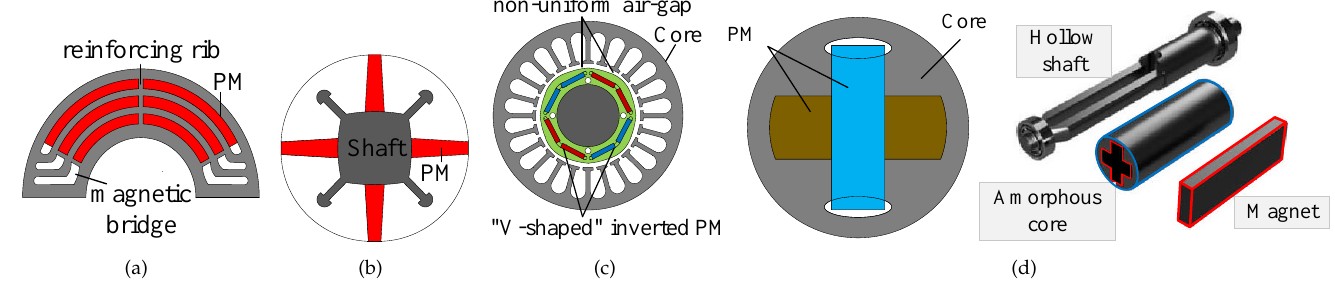
Figure 13. Interior permanent magnet structures of high-speed PM motor: ( a ) Interior permanent magnet segmented structure; ( b ) Interior permanent magnet tangential structure; ( c ) Non-uniform air-gap interior permanent magnet structure; ( d ) Hollow shaft permanent magnet special structure.